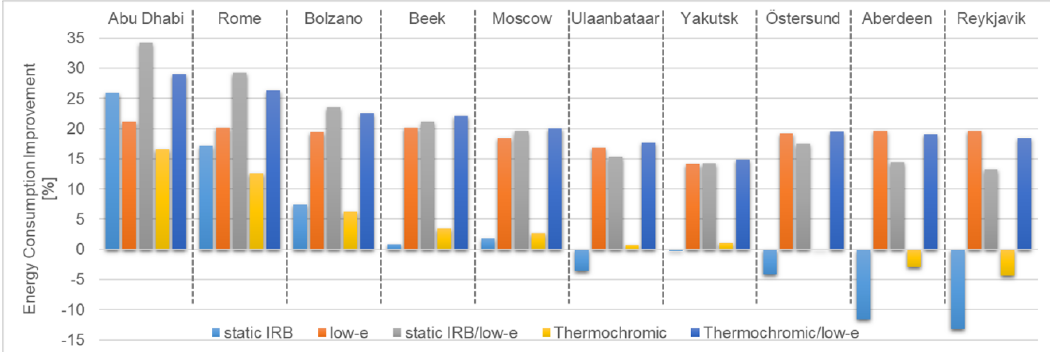
Figure 11. Annual energy consumption improvement of the five studied energy-efficient glazing systems over clear glass, for each of the 10 locations with different climates.